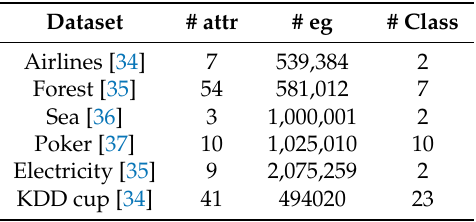
Table 2. A summary of Dataset.